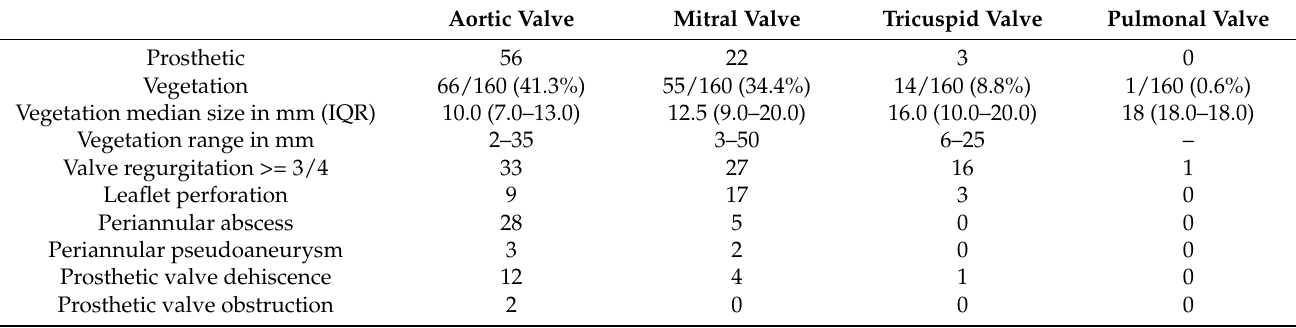
Table A7. Valvular lesions in CVCA registry.